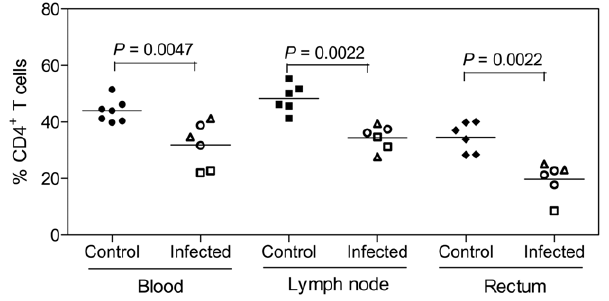
Figure 8. T-cell depletion during acute SHIV-1157ipEL-p viremia. The percent CD4 + T cells in blood, lymph node and gut was estimated compared with cells from naı¨ve monkeys (closed symbols). Biopsy specimens were collected during the acute phase of infection. Two of the 2-week time points were obtained from last two i.v.- inoculated RM used for viral adaptation, the remainder were collected from RM undergoing the 5x weekly i.r. challenge-dose titration. We assigned peak viremia as being week 2 after the pen-ultimate i.r. inoculation, the one that most likely was successful in achieving systemic infection. Individual time points are shown with different symbols (open squares, week 2; open triangles, week 5; open circles, week